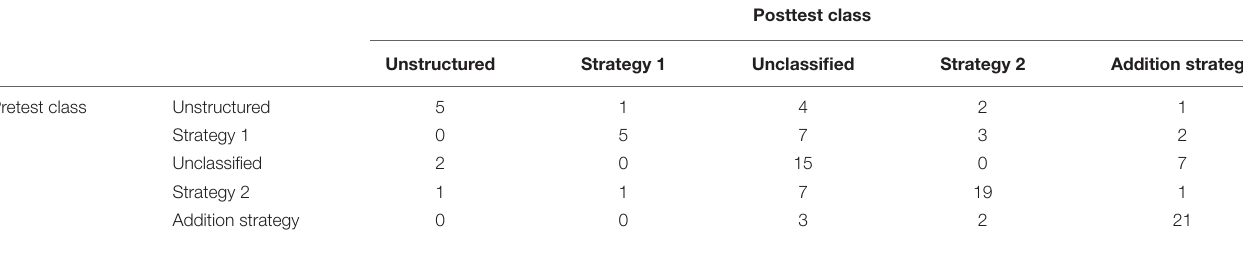
TABLE B2 | Number of children in the balance beam (BB) condition that transitioned from pretest to